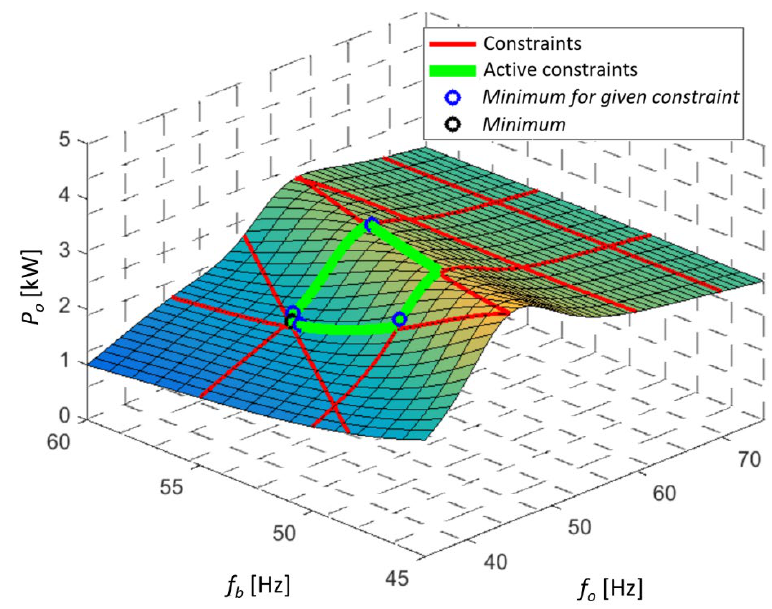
Figure 13. Simulation result of the proposed optimization algorithm.